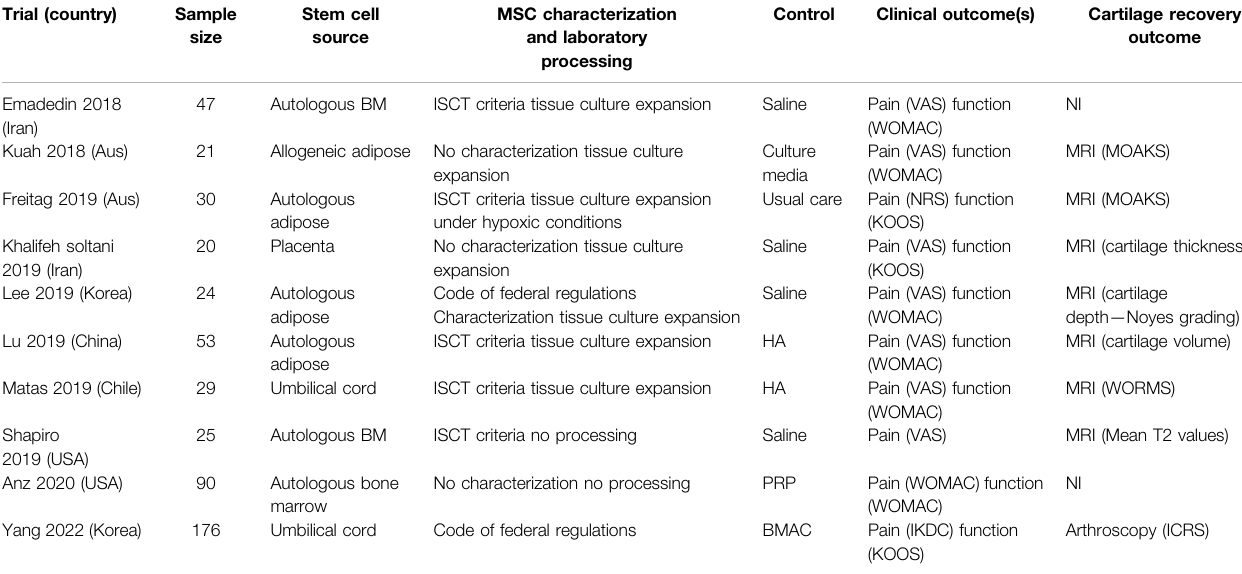
TABLE 1 | Summary of described clinical trials. Trial